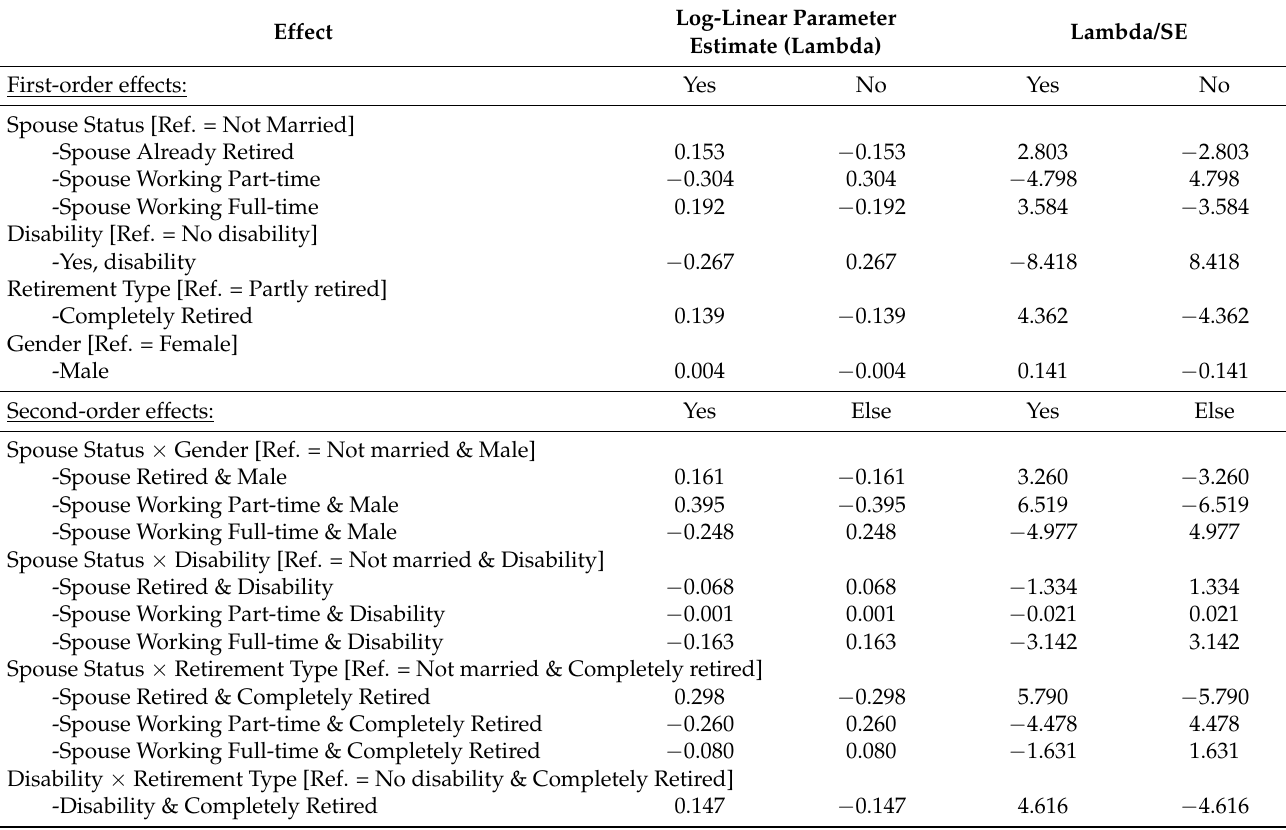
Table 3. Parameter estimates for hierarchical model of socio-structural drivers of